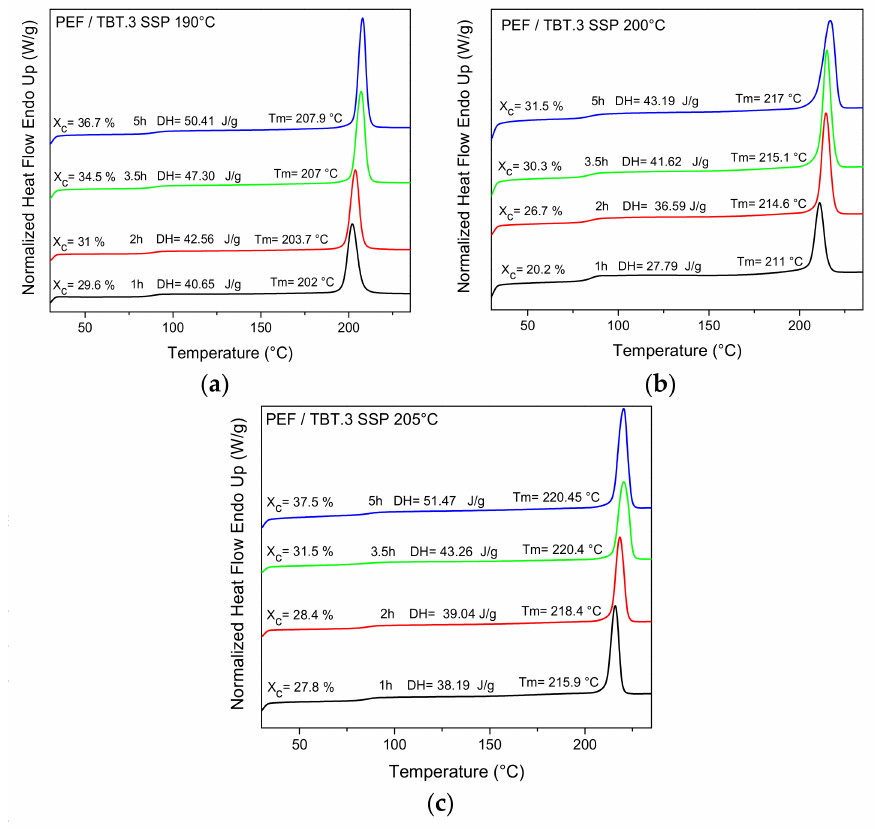
Figure 5. DSC thermograms of PEF/TBT.3 samples prepared after SSP at different temperatures